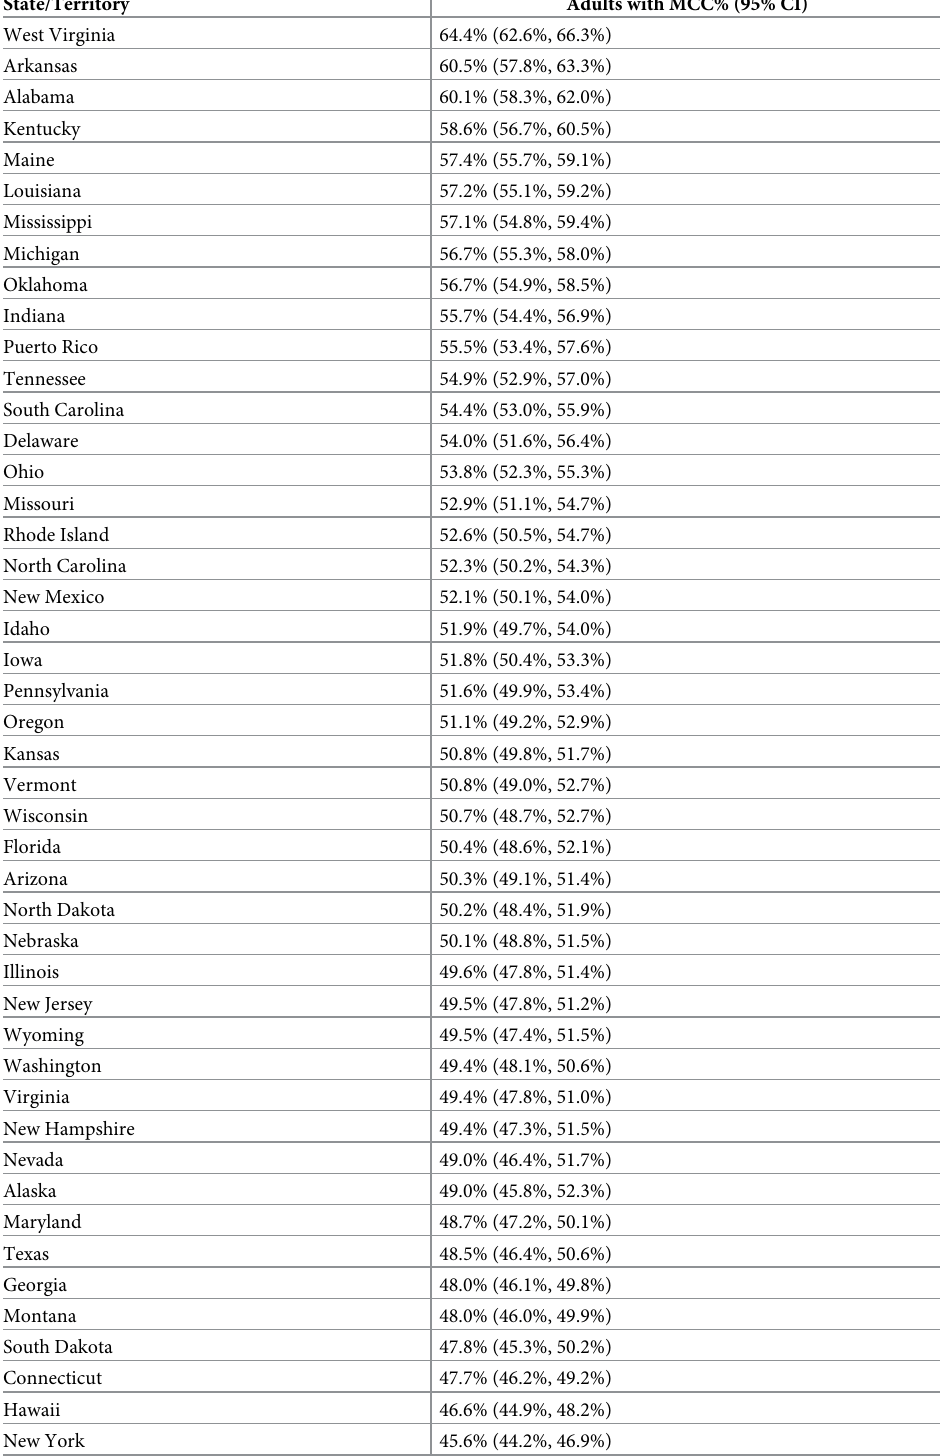
Table 1. Prevalence (highest to lowest) of diagnosed multiple chronic conditions among adults aged � 18 years, by state or territory—Behavioral Risk Factor Surveillance System, United States,